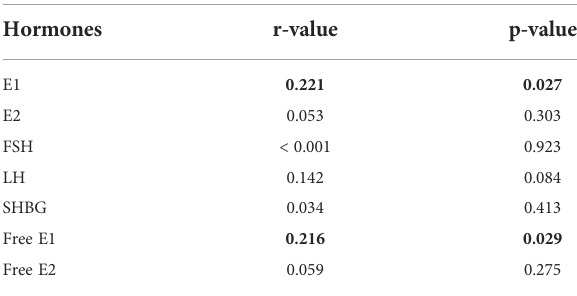
TABLE 4 Correlations of serum hormones with human WAT IL10 mRNA expression in cohort 3 (n=22). Linear